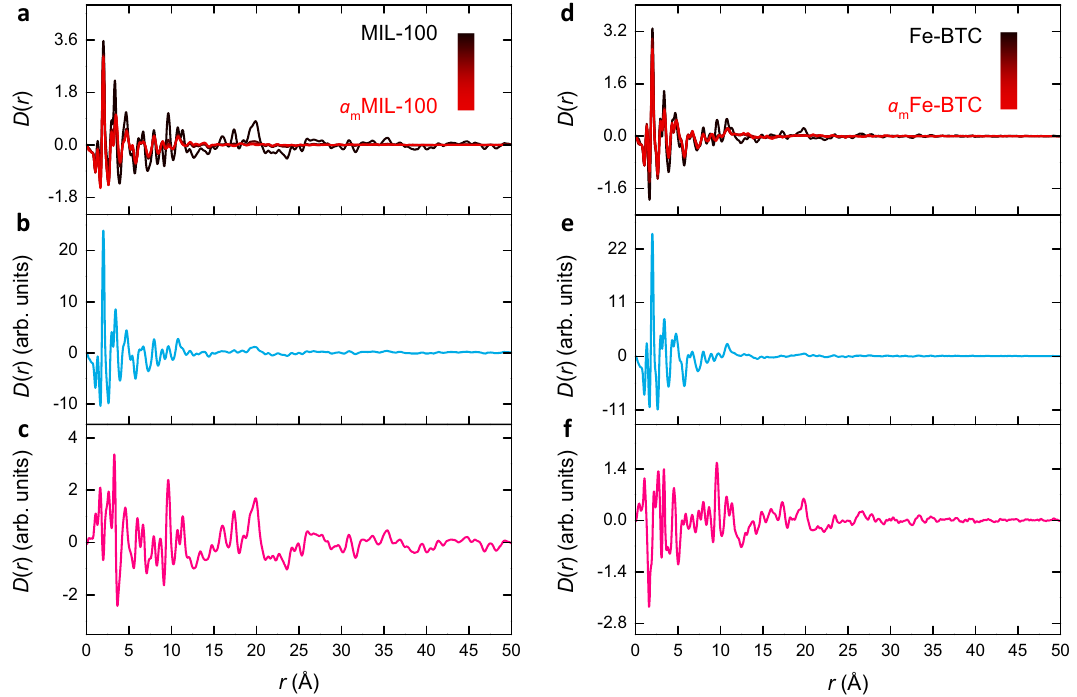
Fig. 5 Structural collapse. a Experimental ex situ PDFs following the collapse of MIL-100 over 30 minutes, the corresponding ( b ) fi rst and ( c ) second principal components extracted through PCA, which describe atom – atom correlations and a structural distortion, respectively. d Experimental ex situ PDFs following the collapse of Fe-BTC over 30 min, the corresponding ( e ) fi rst and ( f ) second principal components which describe atom – atom correlations and a structural distortion,